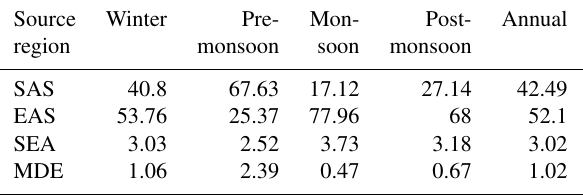
Table 3. Fractional contribution (%) from four major source re- gions including South Asia (SAS), East Asia (EAS), Southeast Asia (SEA), and the Middle East (MDE) to BC surface concentra- tions over the Mt. Yulong region in winter (December–February), pre-monsoon (March–May), monsoon (June–September), post- monsoon (October–November), and all months during the model simulation time period